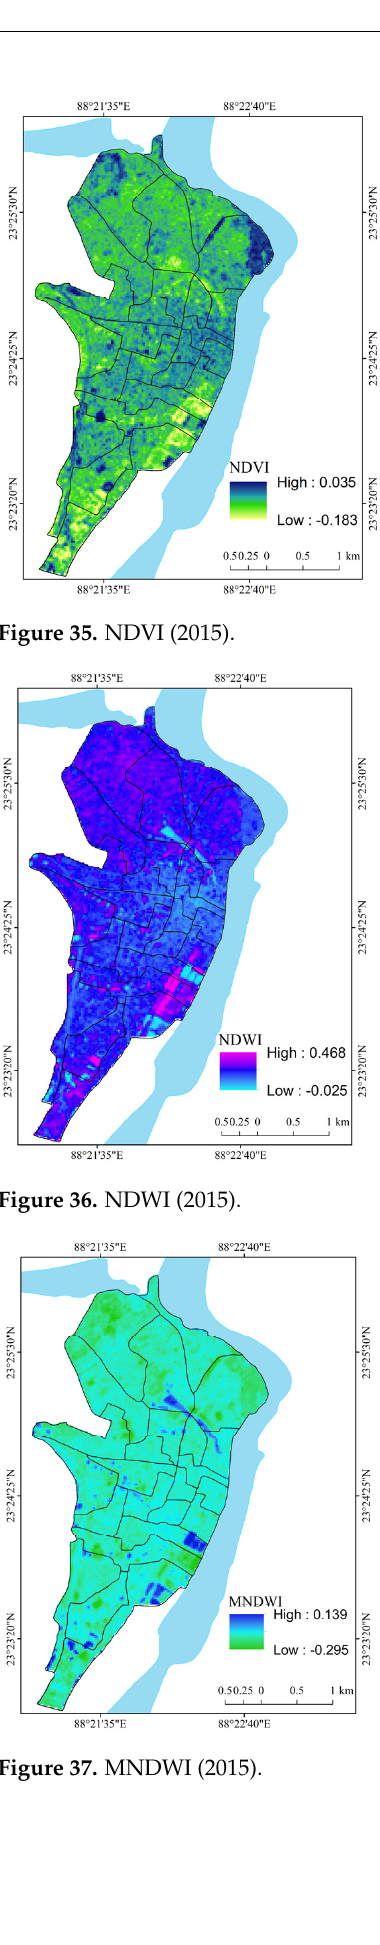
Figure 38. NDBI (2015). Figure 39. NDSI (2015).